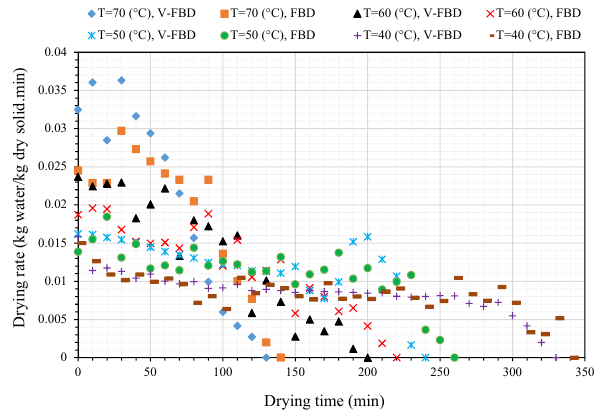
Fig. 11. Drying rate versus drying time at different drying air temperatures with and without vibration (drying air flow rate=26 m 3 /h, vibration intensity=7.5 Hz)